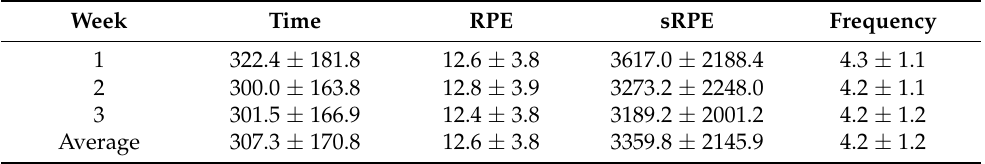
Table 4. Mean and standard deviation of the time (minutes), rate of perceived exertion (RPE), session RPE (sRPE), and frequency (times per week) for the La Crosse Exercise and Health Program and outside